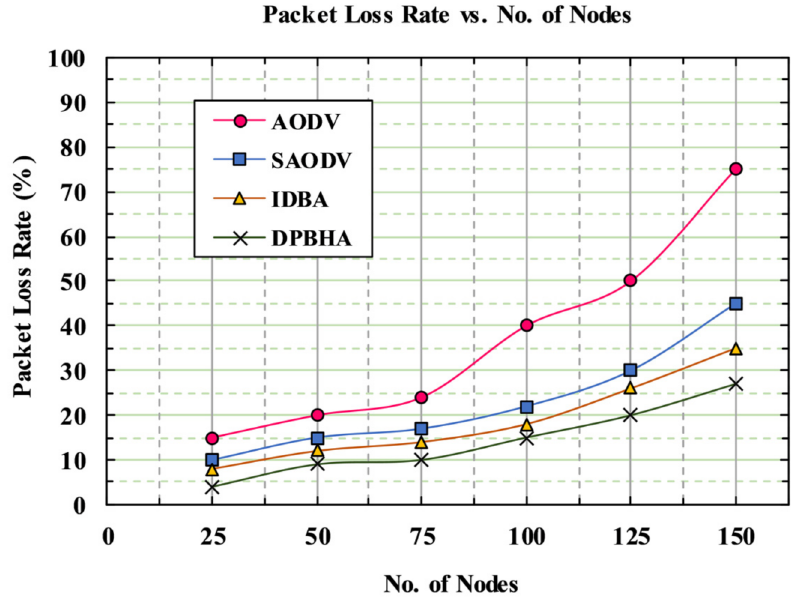
Figure 14. Graphical representation of packet loss